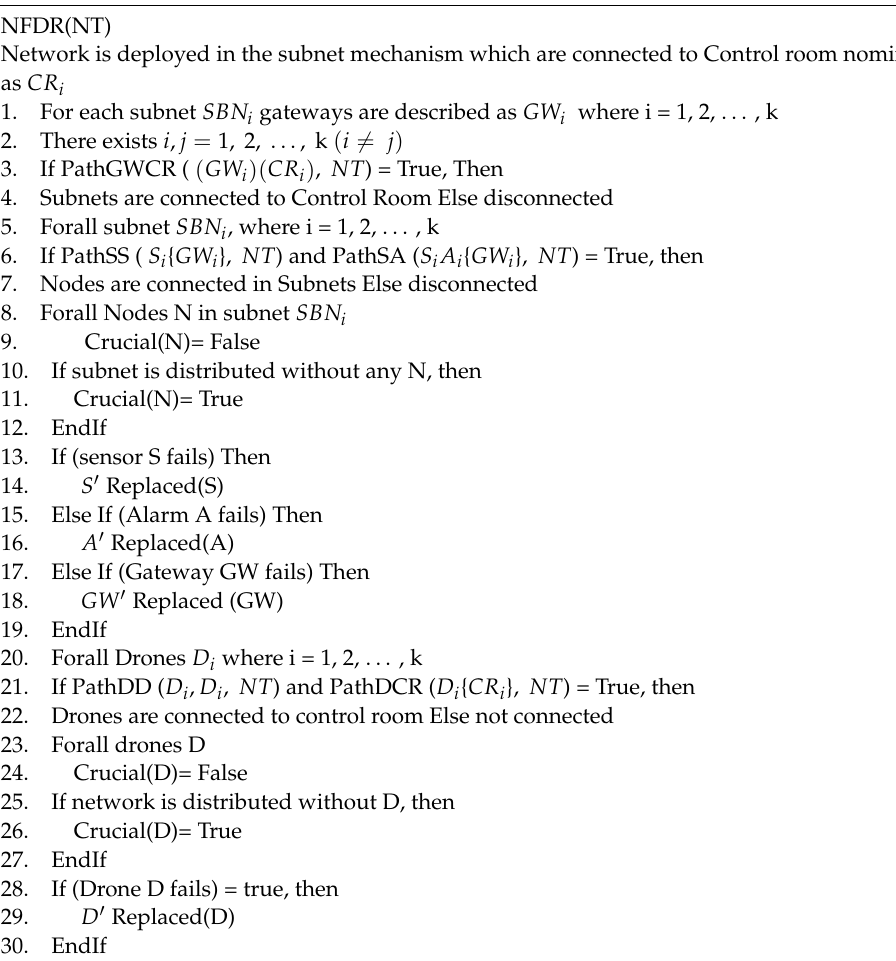
Algorithm 1: Failure detection and